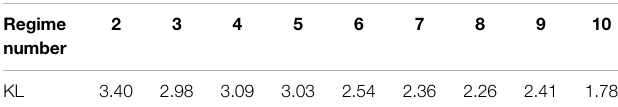
TABLE 1 | The KL value of different regime number (10 ^